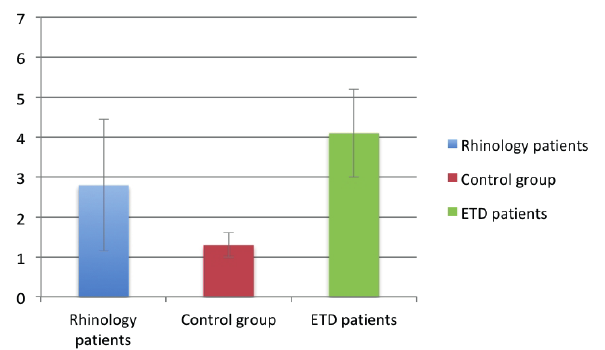
Figure 2. Mean ETDQ-7 scores. There was a significantly higher rate of ETD symptoms (p<0.01 paired t-test) in the rhinology patients (mean score 3.1, SD 1.64) as compared to a control population (mean 1.3, SD 0.3). The error bars show the standard deviation.